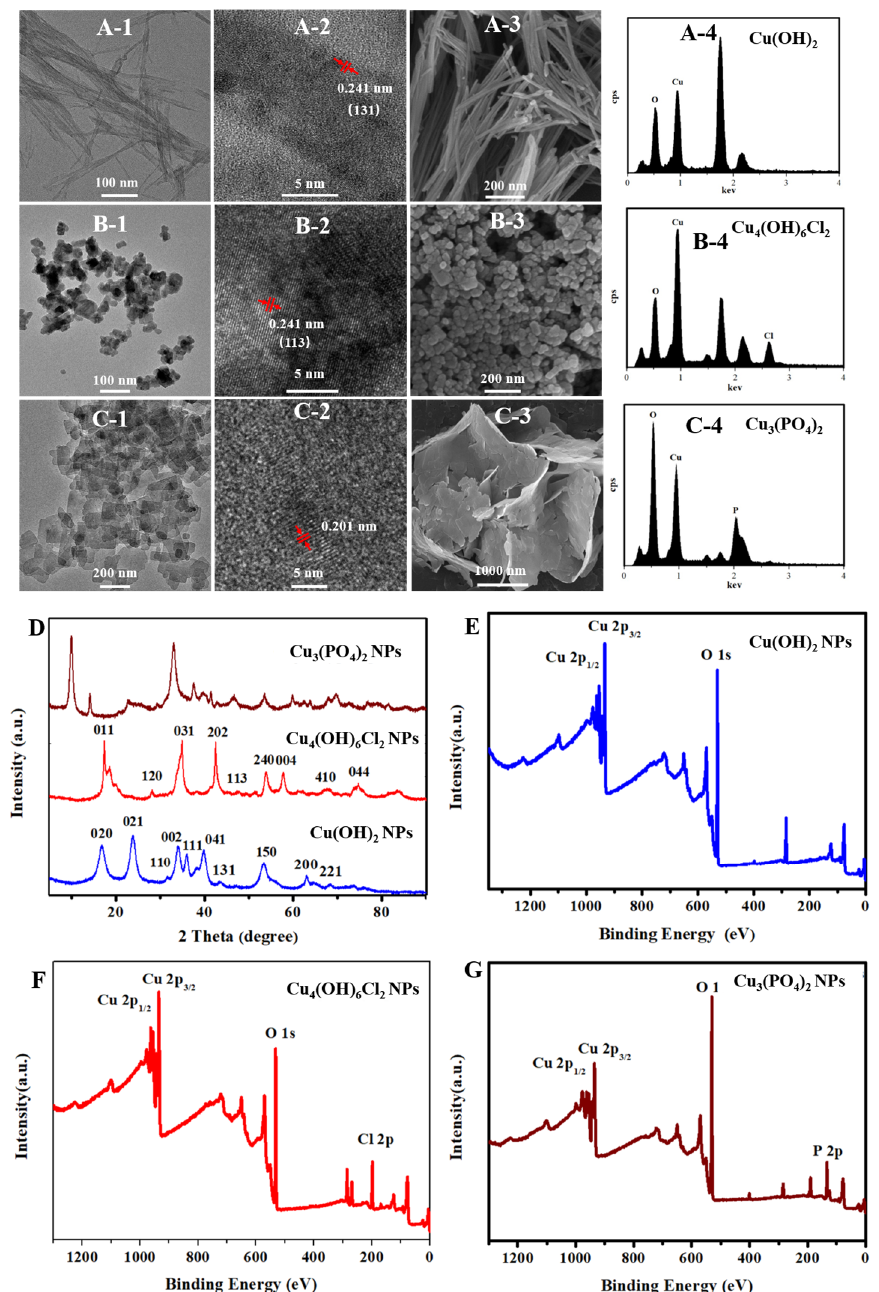
Figure 1. Characterization of copper-based nanomaterials. TEM ( A-1 ), HR-TEM ( A-2 ), SEM ( A-3 ) and EDS ( A-4 ) image of Cu(OH) 2 nanowires; TEM ( B-1 ), HR-TEM ( B-2 ), SEM ( B-3 ), and EDS ( B-4 ) image of Cu 3 (PO 4 ) 2 · 3H 2 O nanosheets; TEM ( C-1 ), HR-TEM ( C-2 ), SEM ( C-3 ), and EDS ( C-4 ) image of copper oxychloride nanoparticles. XRD pattern of Cu(OH) 2 nanowires, Cu 3 (PO 4 ) 2 · 3H 2 O nanosheets, and Cu 4 (OH) 6 Cl 2 nanoparticles ( D ). XPS survey spectra of Cu(OH) 2 nanowires ( E ), Cu 3 (PO 4 ) 2 · 3H 2 O nanosheets ( F ), and Cu 4 (OH) 6 Cl 2 nanoparticles ( G